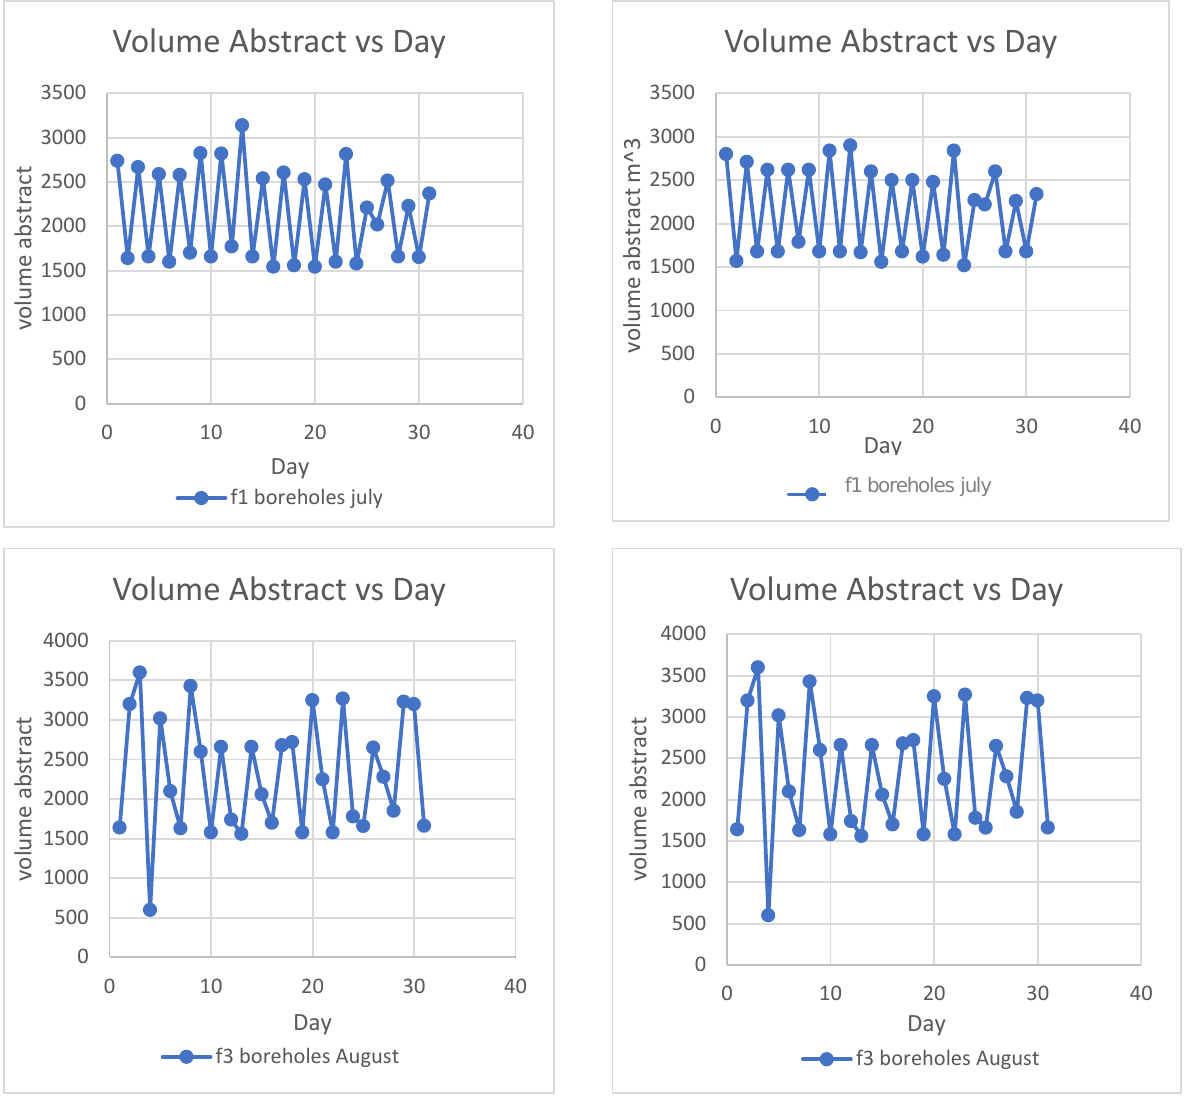
Figure 16. Volume abstracted daily in Regideso.